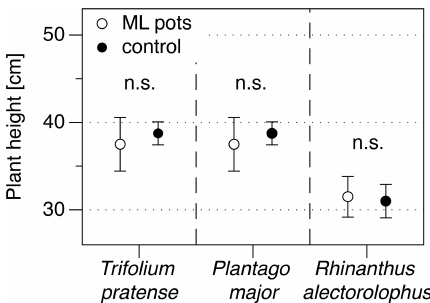
Figure 6. Comparison of plant height of three plant species at CH- FRU (measured on 26 May 2019) growing in ML pots vs. the same species growing in the open field (control). Error bars show stan- dard errors ( n = 3), and n.s. stands for no statistically significant